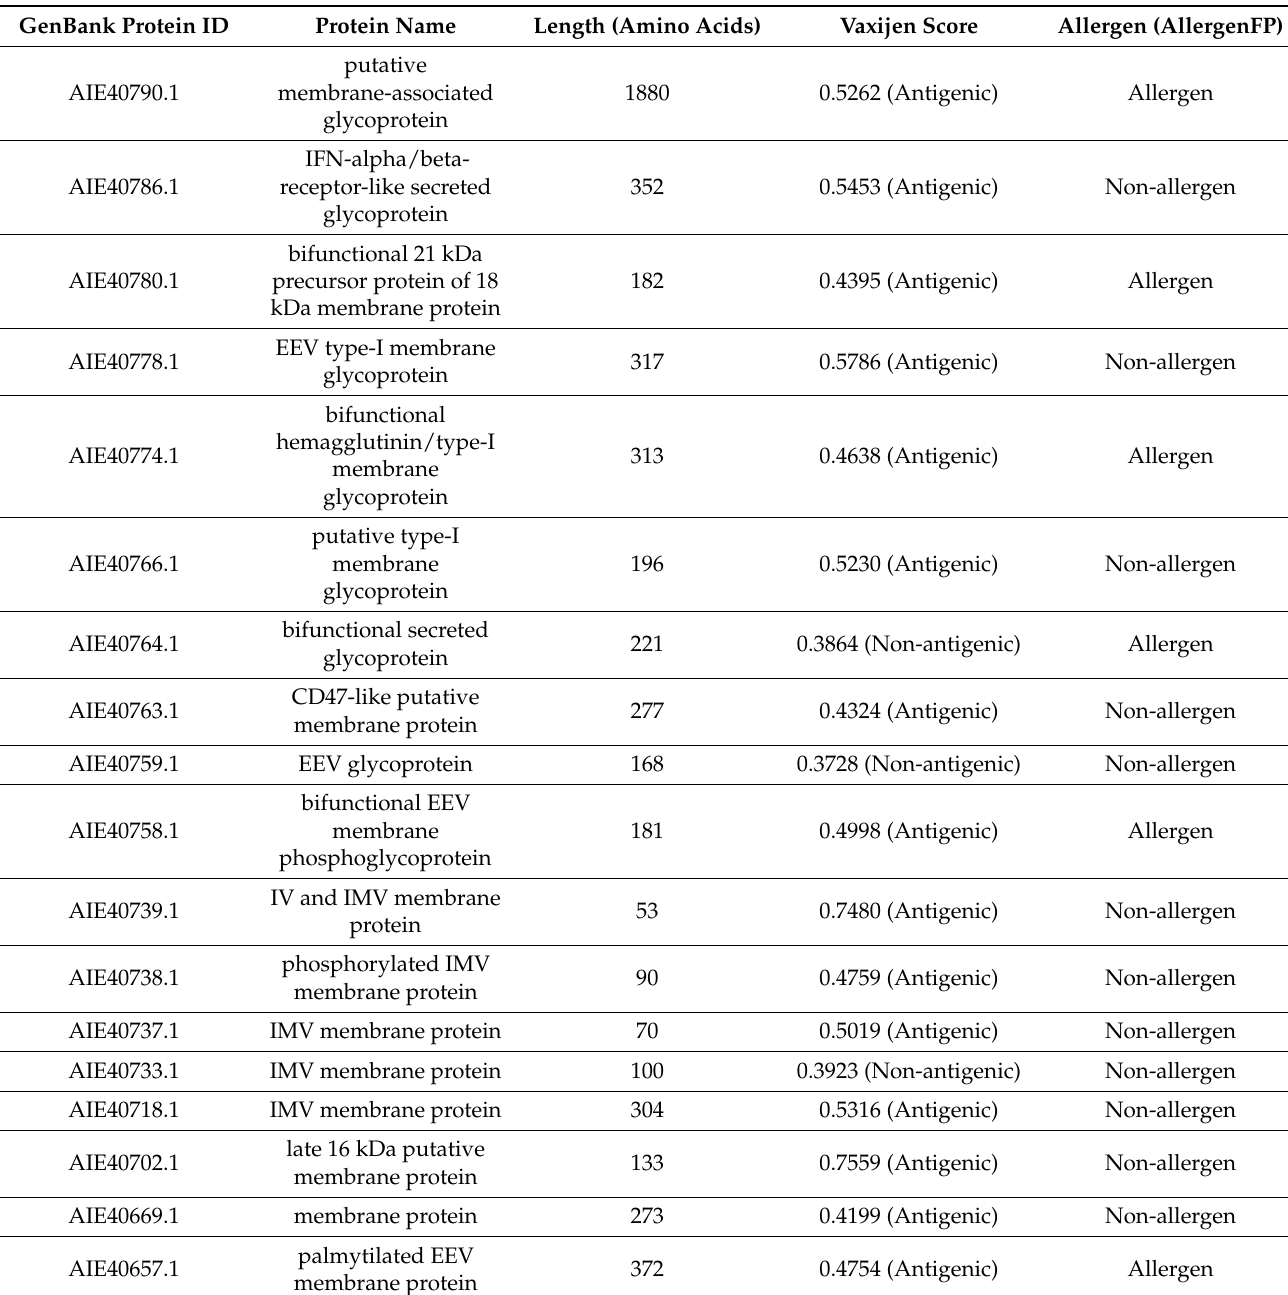
Table 1. Glycoproteins and membrane proteins of monkeypox virus strain W-Nigeria and their antigenic and allergic